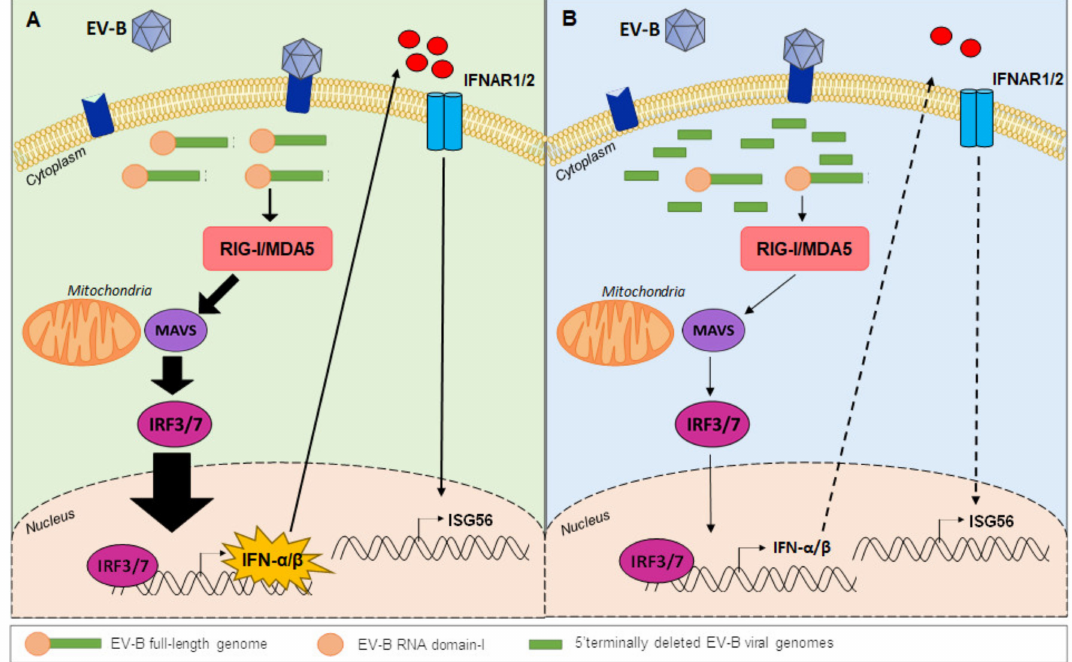
Figure 6. Natural 5 (cid:48) terminally deleted group-B enterovirus RNA forms can modulate type I interferon signaling pathway activation. ( A ) Full-length viral RNA is recognized by cytoplasmic sensors RIG-I or MDA5 in EV-B infections. Signaling through the adaptor protein MAVS leads to IRF3 activation and translocation to the nucleus. These molecules stimulate high level of IFN- α / β and ISG56 production for the development of e ff ective antiviral responses to EV-B infections. ( B ) According to recent reports, deleted viral genomes were associated with parental complete virus in early phase group-B enterovirus infection. Host cell proteins recruited in viral RNP complexes or potentially acting as a restriction factors could provide an evolutionary advantage to the 5 (cid:48) NCR truncated viral RNA forms. Deletion in RNA domain-I (5 (cid:48) terminally deleted viral genomes) could impair the viral genomic RNA recognition by RLRs (RIG-I or MDA5) immune sensors during the early phase of antiviral innate immune response resulting in low level of IFN- α / β and ISG56 production. IFN: interferon; RIG-I: retinoic acid-inducible gene-I; MDA5: melanoma di ff erentiation-associated protein 5; MAVS: mitochondria antiviral-signaling